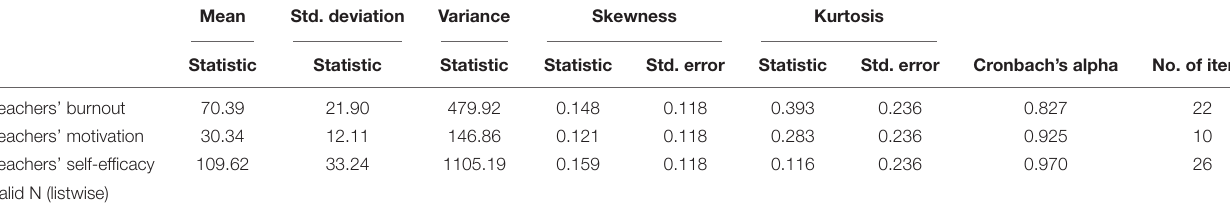
TABLE 1 | Results of Cronbach’s alpha and descriptive statistics for the three instruments.